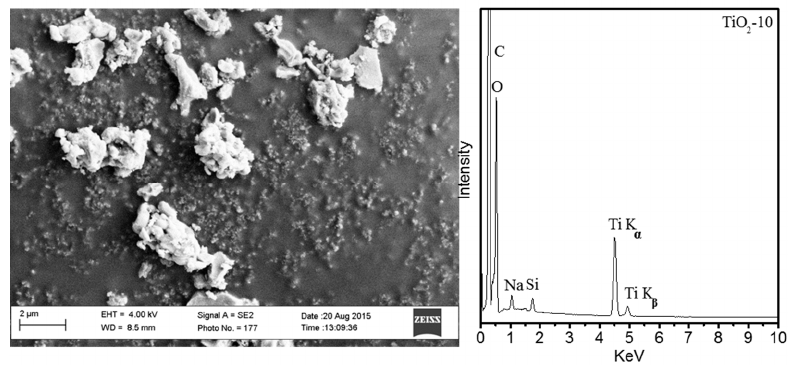
Figure 8. SEM image of TiO 2 -10 hard templated-TiO 2 mesoporous material and EDX mapping of this material.